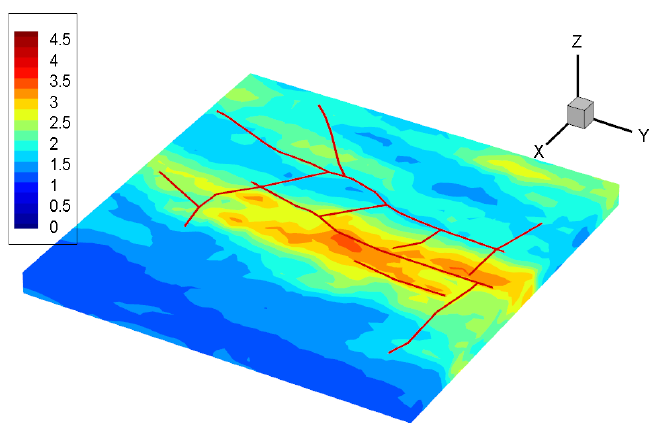
Figure 10. Log-normal permeability